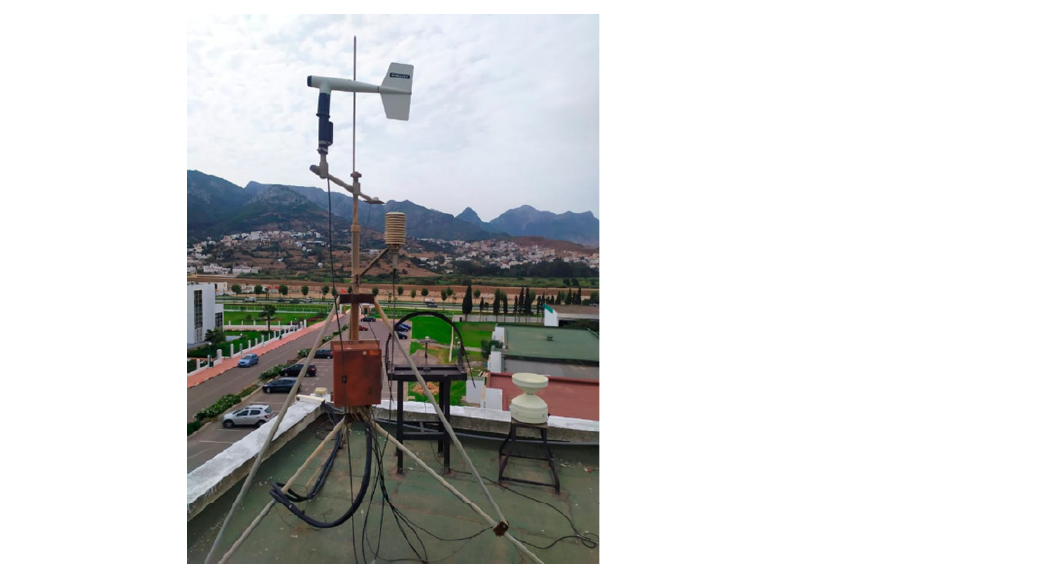
Figure 2. Mean, maximum, and minimum daily temperature of Tetouan and Tangier sites.